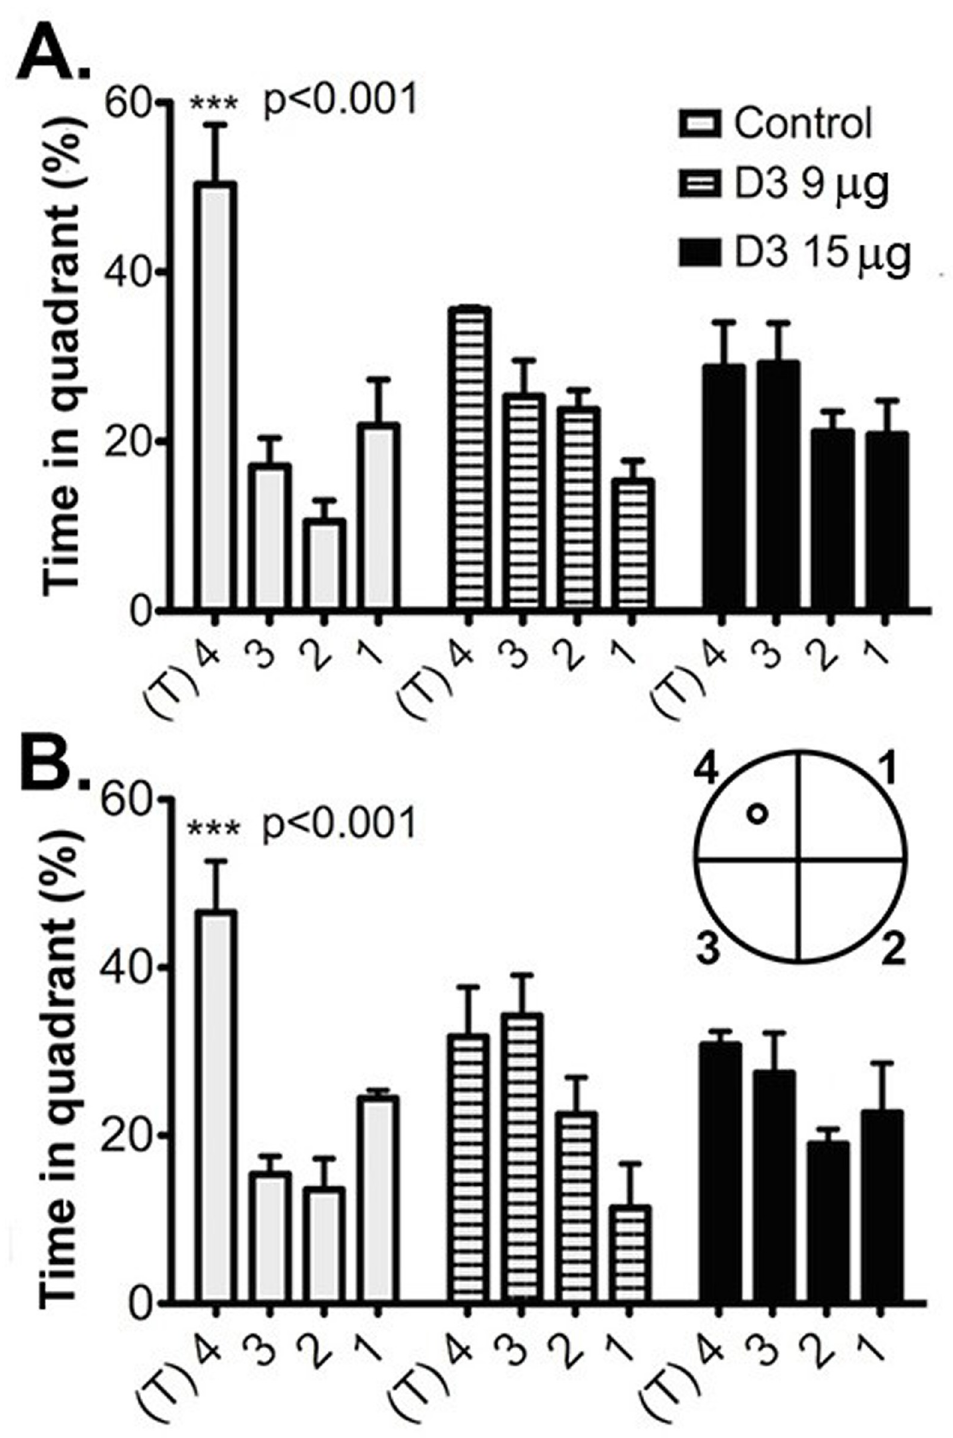
Fig 1. D3-treated mice do not spend significantly more time in the target quadrant during the probe trials. This experiment was replicated two independent times. (A) Probe Trial 1: Vehicle-treated (control, n = 4) mice spent significantly more time in the target quadrant ‘4’ (T) than in the remaining quadrants (p < 0.001). Neither the D3 9 μ g- treated mice (n = 3) nor the D3 15 μ g-treated mice (n = 5) spent significantly more time in the target quadrant. (B) Probe Trial 2: One week later, equivalent results were obtained. Controls spent significantly more time in the target quadrant